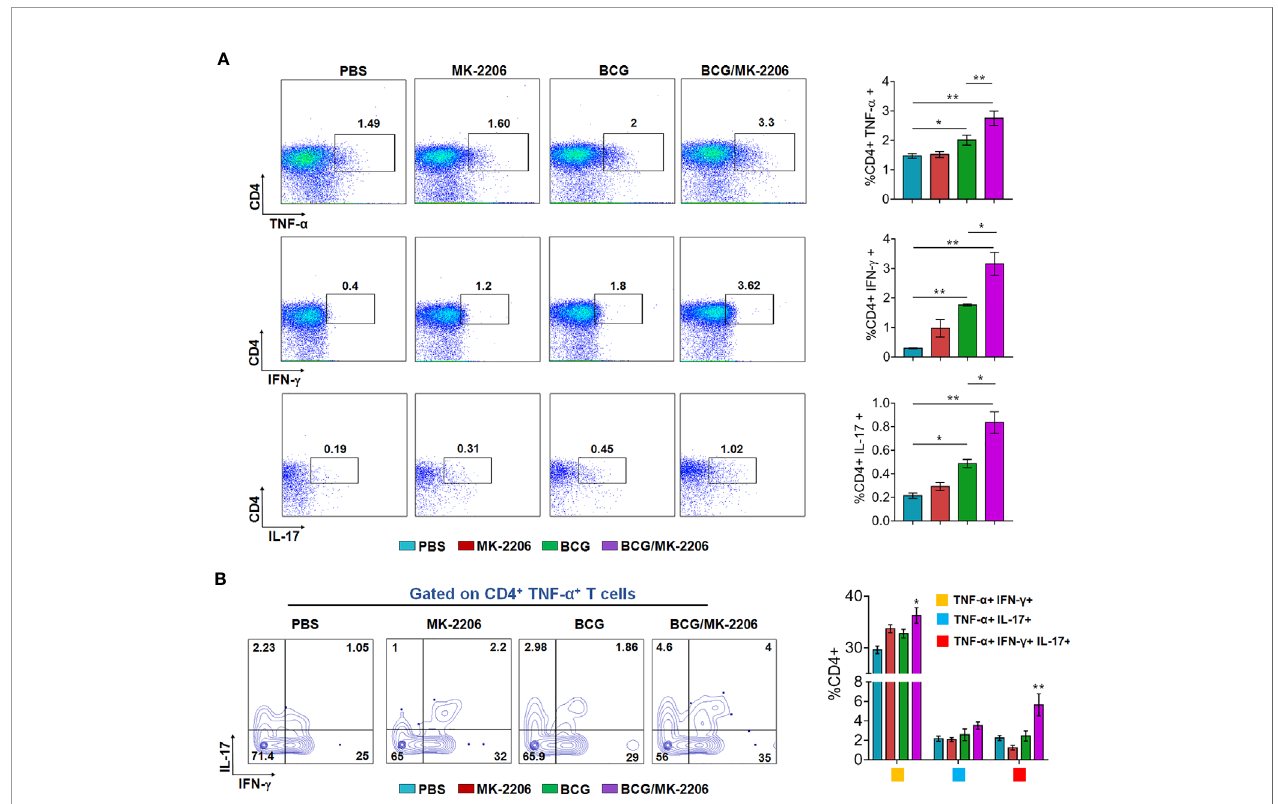
FIGURE 3 | MK-2206 increases Ag-speci fi c multifunctional CD4 + T cell responses in vaccinated mice. Each group of mice was vaccinated as described in Materials and Methods section. Twenty-one days after immunization, mice from each group (n=5) were euthanized and their splenocytes were incubated ex-vivo with PPD for 48 h in the presence of Golgi stop. (A) Representative dot plots showing the frequency of PPD-speci fi c CD4 + cells producing TNF- a or IFN- g or IL-17. Data was analyzed by multicolor fl ow cytometry by gating on CD3 + CD4 + lymphocytes. (B) Multifunctional cells were identi fi ed by gating on CD4 + TNF- a + , T cells. Representative FACS plots show the frequencies of CD4 + T cells co-expressing TNF- a and/or IFN- g and/or IL-17. The data shown in this panel is mean ± SEM obtained from a single experiment (n=5 mice/group). Statistical differences were obtained for the indicated groups. *p < 0.05; **p <